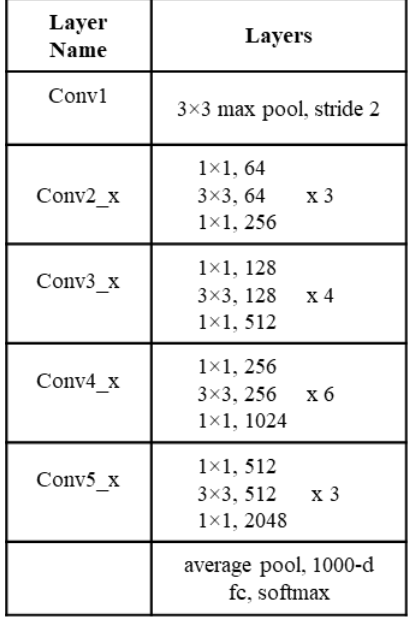
Table 1. The architecture of ResNet50 model (He et al., 2015)